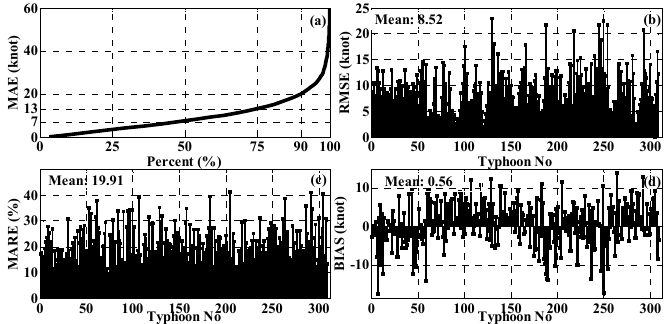
Figure 4. N-fold cross validation of the model using the 325 cases in the northwestern pacific Ocean during the time period from 1996 to 2007. ( a ) The cumulative distribution of the absolute errors. ( b ) The root mean square error for each left out case. ( c ) The absolute relative error for each left out case. ( d ) The bias for each left out case.